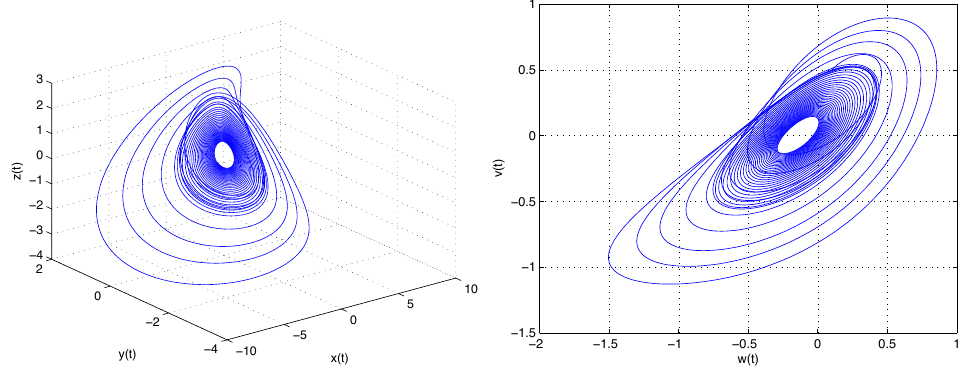
Figure 3. One-scroll attractors of the system (18) in state space ( left ) and state plane ( right